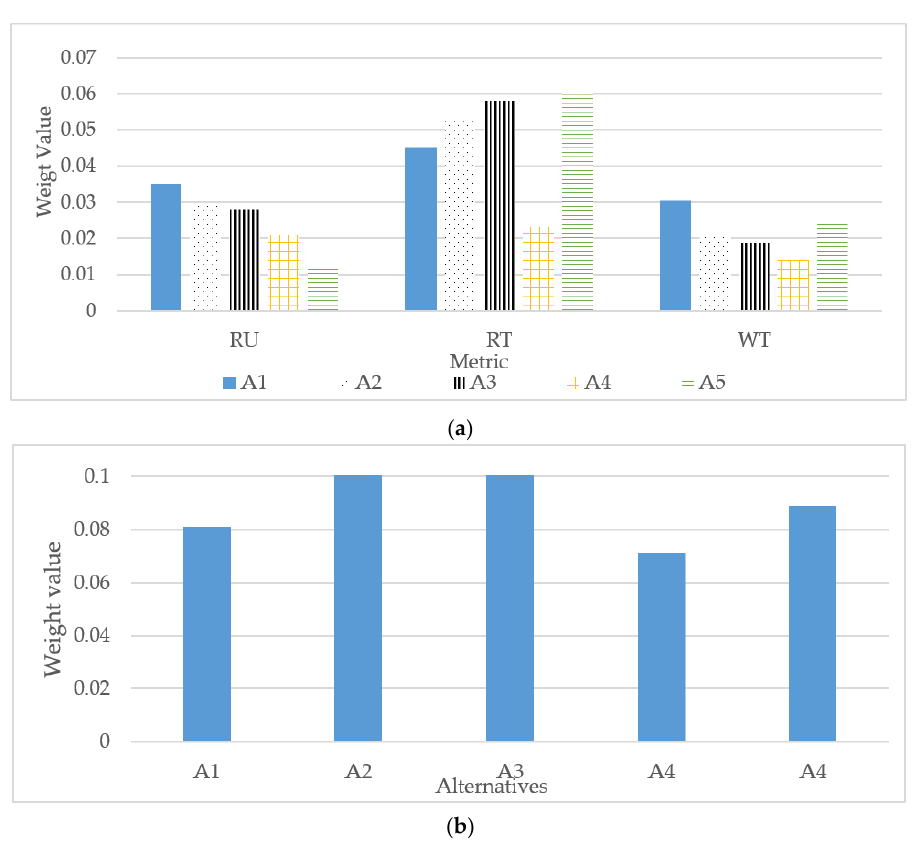
Figure 12. Weight rank for case 1 according to the metrics: ( a ) weight value and ( b ) alternative score .